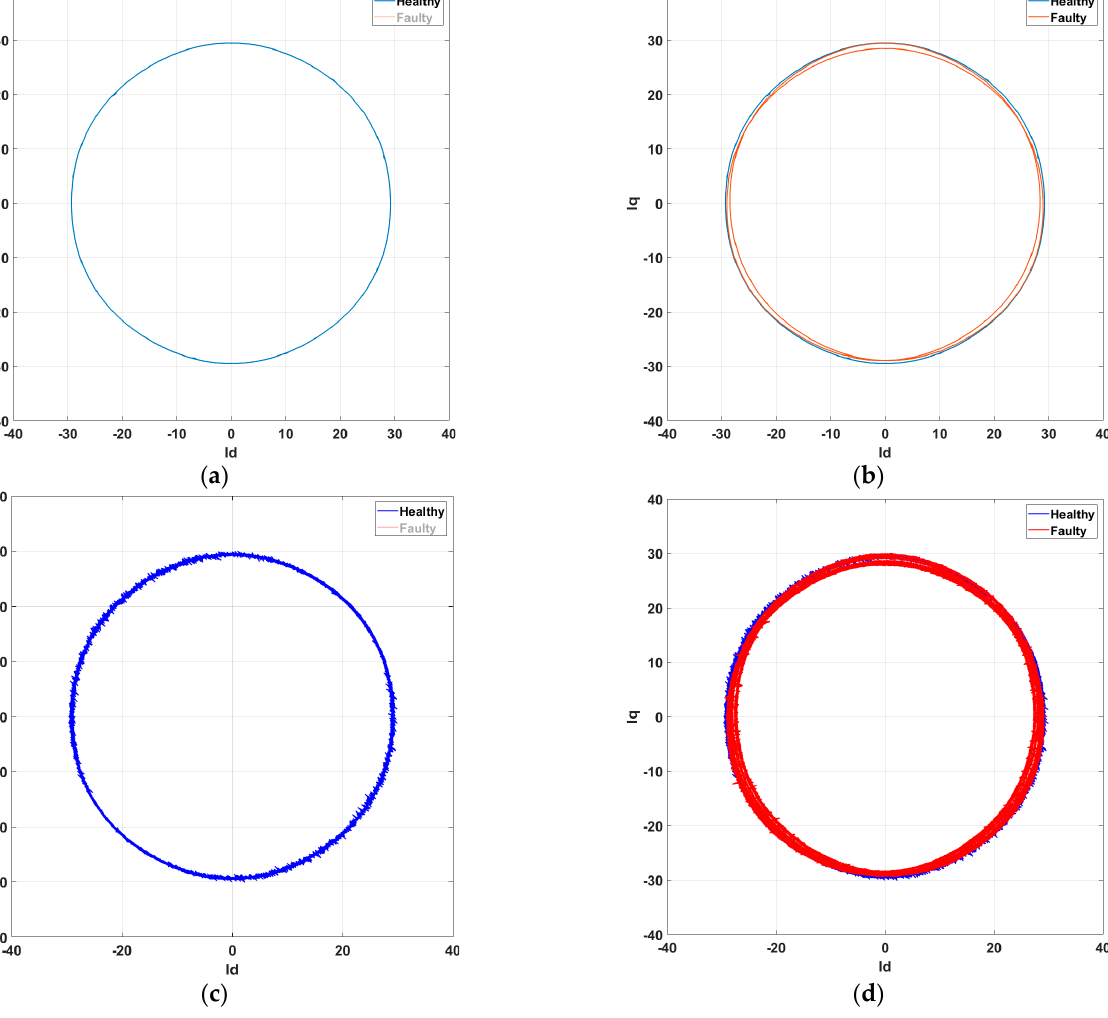
Figure 4. Simulation results. PVA of the generator at 100 rpm: ( a ) healthy simulation; ( b ) local demagnetization simulation; ( c ) healthy experiment; ( d ) local demagnetization experiment.